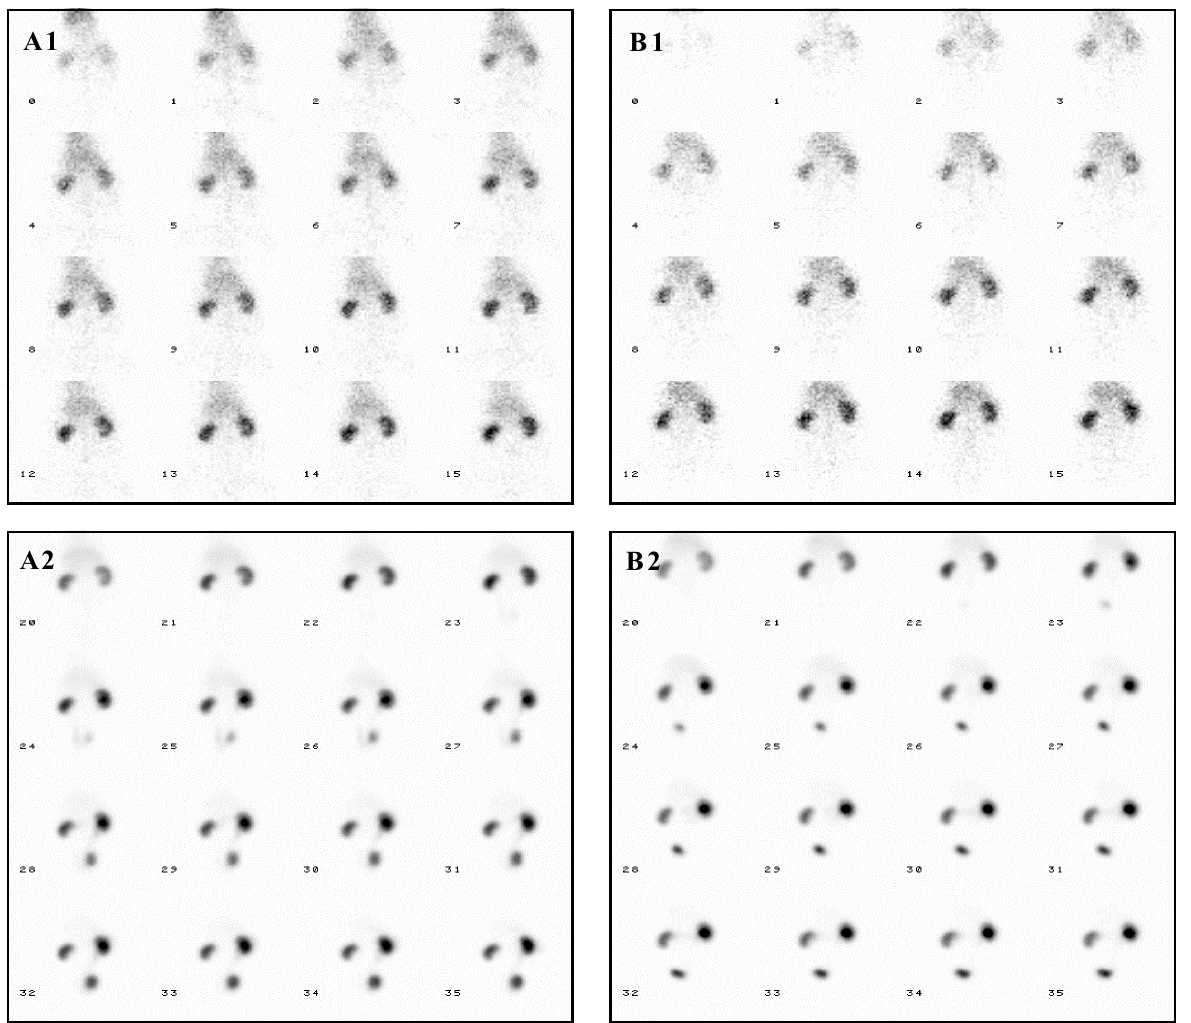
Figure 01 - Control Group (Group A). Basal study (A1 and A2), with perfusion (A1) and function (A2) phases, showing preserved function in both kidneys, so as pervious urinary pathways (back view). Second study 24 hours after surgery (B1 and B2), without ischemia, and so, without pattern changes